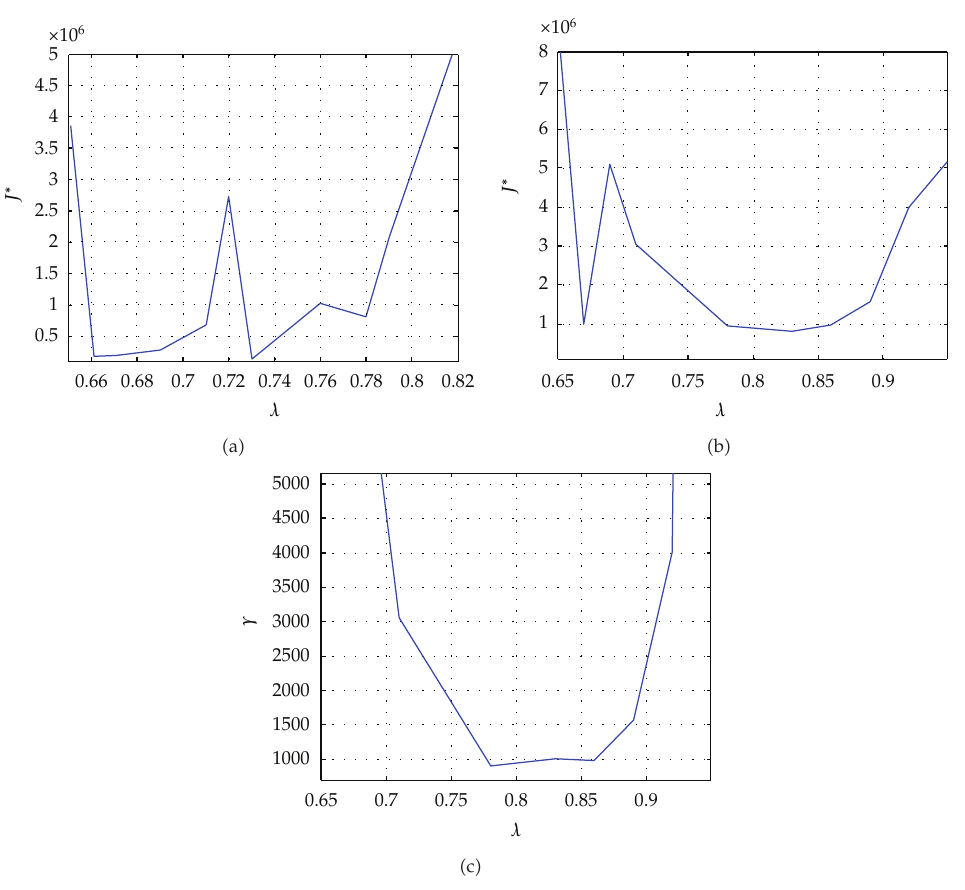
Figure 2: (cid:2) a (cid:3) The guaranteed cost J ∗ via di ff erent λ . (cid:2) b (cid:3) The guaranteed cost J ∗ via di ff erent λ for every corresponding solvable γ . (cid:2) c (cid:3) Di ff erent λ for every corresponding solvable γ .